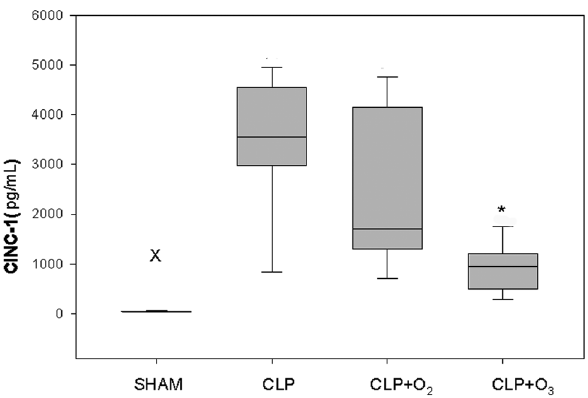
Figure 2 - Kruskal-Wallis test for CINC-1 levels 24 h after the initial pro- cedure. SHAM animals had the lowest levels of all groups. Group CLP+O had CINC-1 levels significantly lower than groups CLP and CLP+O Group SHAM vs. other groups ( P <0.01). * Group CLP+O and CLP+O ( P <0.05). Values of CINC-1 are medians (P25;P75) expressed 2 in pg/mL.